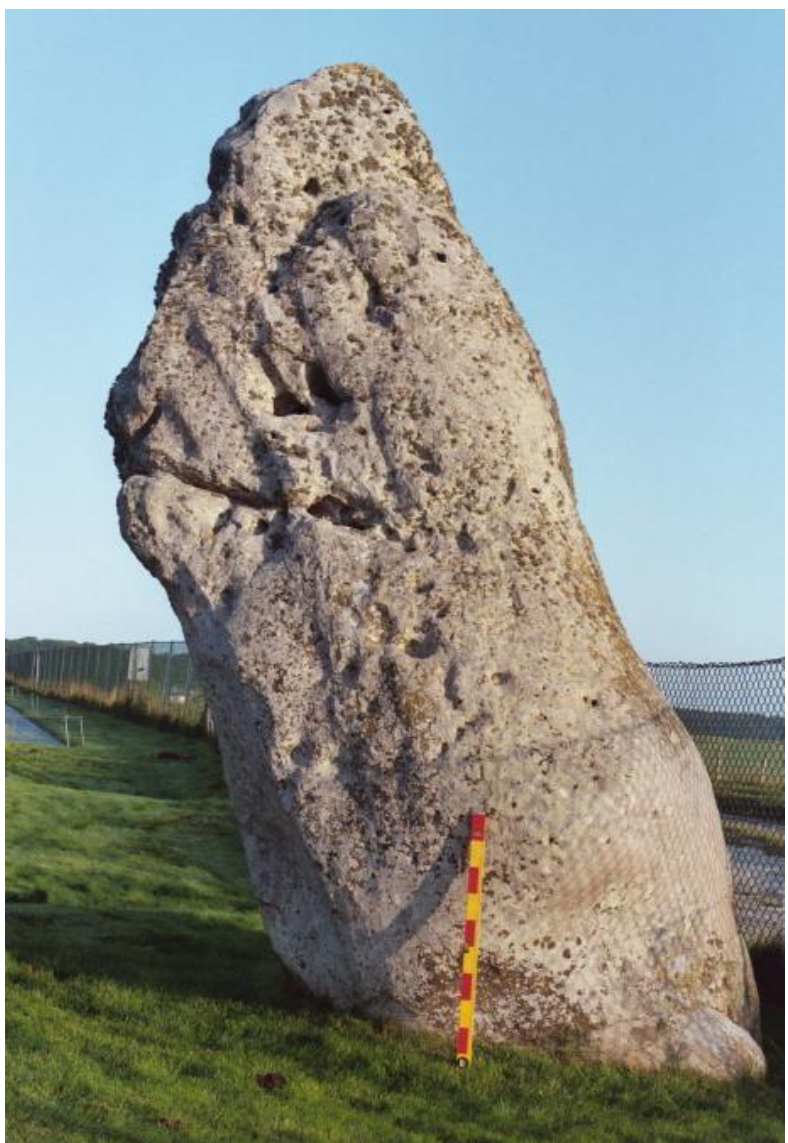
Figure 1. The Heel Stone stands outside the monument beyond the henge ditch and bank. (Photograph by the